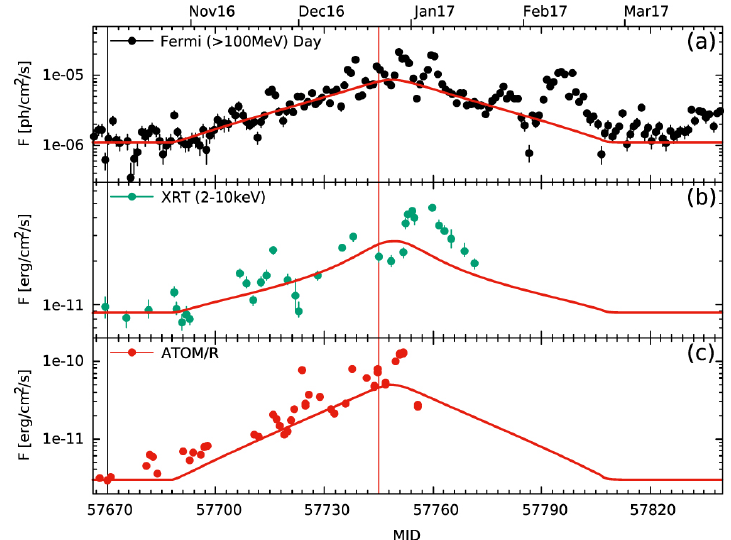
Figure 12. Fits to the ∼ 4 months-long multi-wavelength outburst of CTA 102 in 2016–2017 in γ -rays ( a ), X-rays ( b ), and optical ( c ) using a model of cloud ablation by the blazar jet. From [121]. Reproduced with permission from the American Astronomical Society